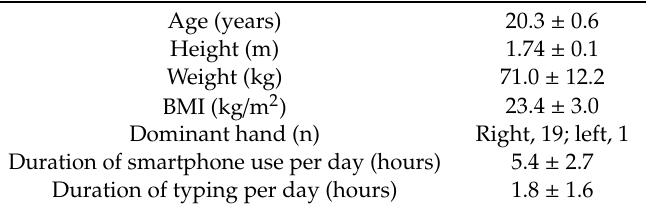
Table 1. Participant characteristics ( n = 20).